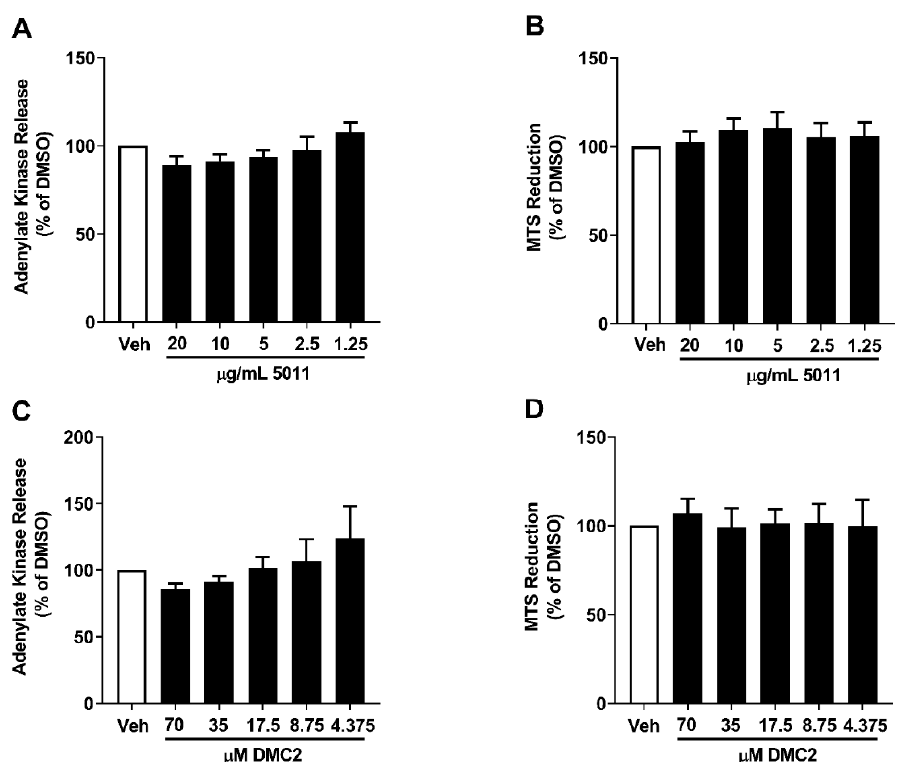
Figure 1. PMI 5011 (5011) and DMC2 do not promote β -cell toxicity. 832/13 cells were treated for 6 h with DMSO vehicle (Veh) or the indicated concentrations of both PMI 5011 ( A , B ) and DMC2 ( C , D ). Adenylate kinase release into the media ( A , C ) and MTS reduction ( B , D ) were determined. Data are shown as means ± SEM from 6 individual experiments.